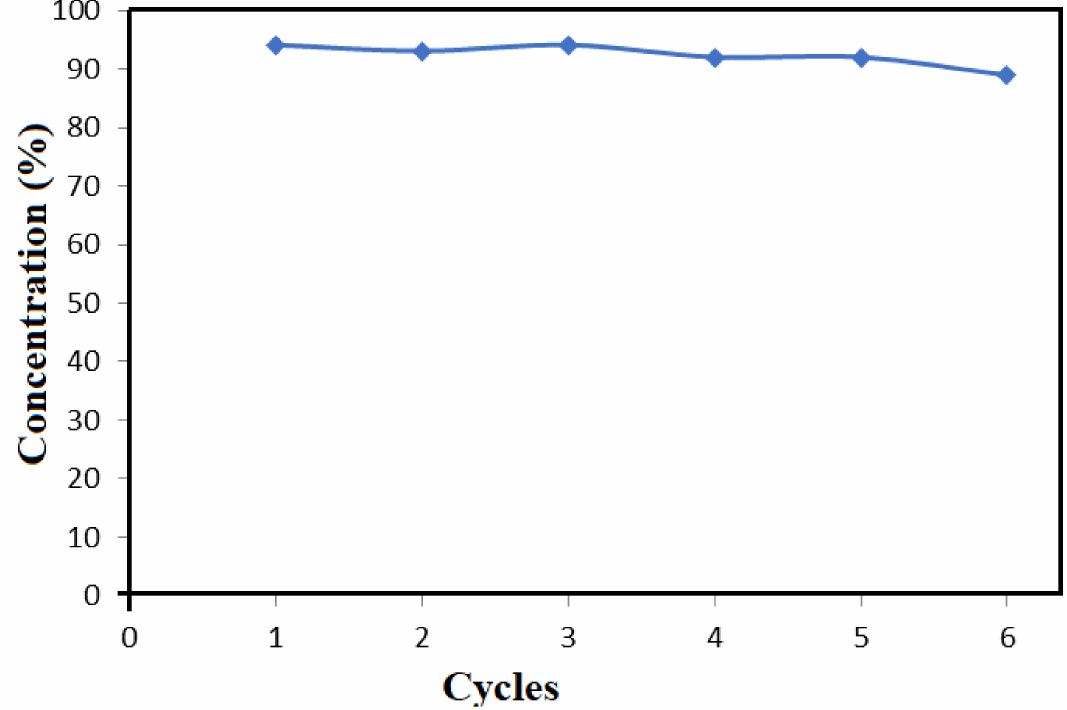
Figure 7. Degree of photocatalytic removal of Brilliant blue in reusability tests with TiO 2 -SnO 2 (dye concentration was about 5 mg per L solution and the reaction time was about 15